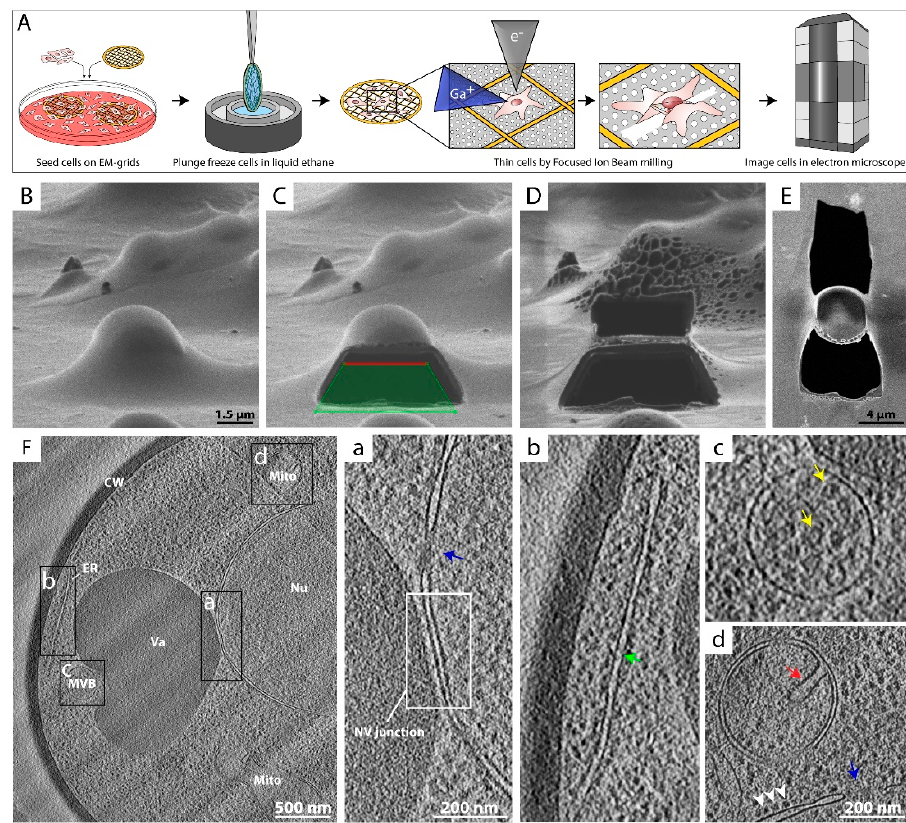
Figure 3. Cryo-focused ion beam (cryo-FIB) milling to analyze structures in situ. ( A ) Sample preparation workflow utilizing FIB milling followed by cryo-ET. Eukaryotic cells are directly grown on or applied to EM grids, vitrified and transferred to a cryo-FIB-scanning electron microscope (cryo-FIB-SEM). A thin lamella of the desired region in the cell is generated by ablating material above and below the position of interest, using a focused beam of gallium ions (Ga + ) (Scheme was modified from [79]). The progress is monitored by SEM imaging (e − ). Next, the grid is transferred to a transmission electron microscope for cryo-ET data acquisition. ( B – D ) Images of a yeast cell acquired during the FIB milling process from the perspective of the ion beam. ( B ) Intact vitrified yeast cell. ( C ) Yeast cell where the lower part of the cell was removed by the gallium beam. Green tetragon reflects the shape used to direct the gallium beam ablation. ( D ) Remaining ~450 nm thick lamella of the yeast cell. ( E ) SEM image of the produced yeast lamella. Most of the cell volume and the supporting material underneath were removed. ( F ) A 20 nm thick slice through a cryo-tomogram of a FIB-milled yeast cell, acquired at a defocus of − 5 µ m. Di ff erent cellular compartments are labeled: cell wall (CW), mitochondria (Mito), vacuole (Va), endoplasmic reticulum (ER), multi-vesicular body (MVB), and nucleus (Nu). Areas framed black are magnified on the right. ( a ) Close proximity of the nucleus and the vacuole. The interface between the nucleus and the vacuole (framed NV junction) and a nuclear pore complex (NPC, blue arrow) are shown. ( b ) Peripheral ER (green arrow) at the plasma membrane. ( c ) MVB with internal vesicular densities (yellow arrows). ( d ) Mitochondrion with typical cristae (red arrow). In the lower part, ribosomes (white arrowheads) coating the outer nuclear membrane and a NPC pore (blue arrow) are visualized.